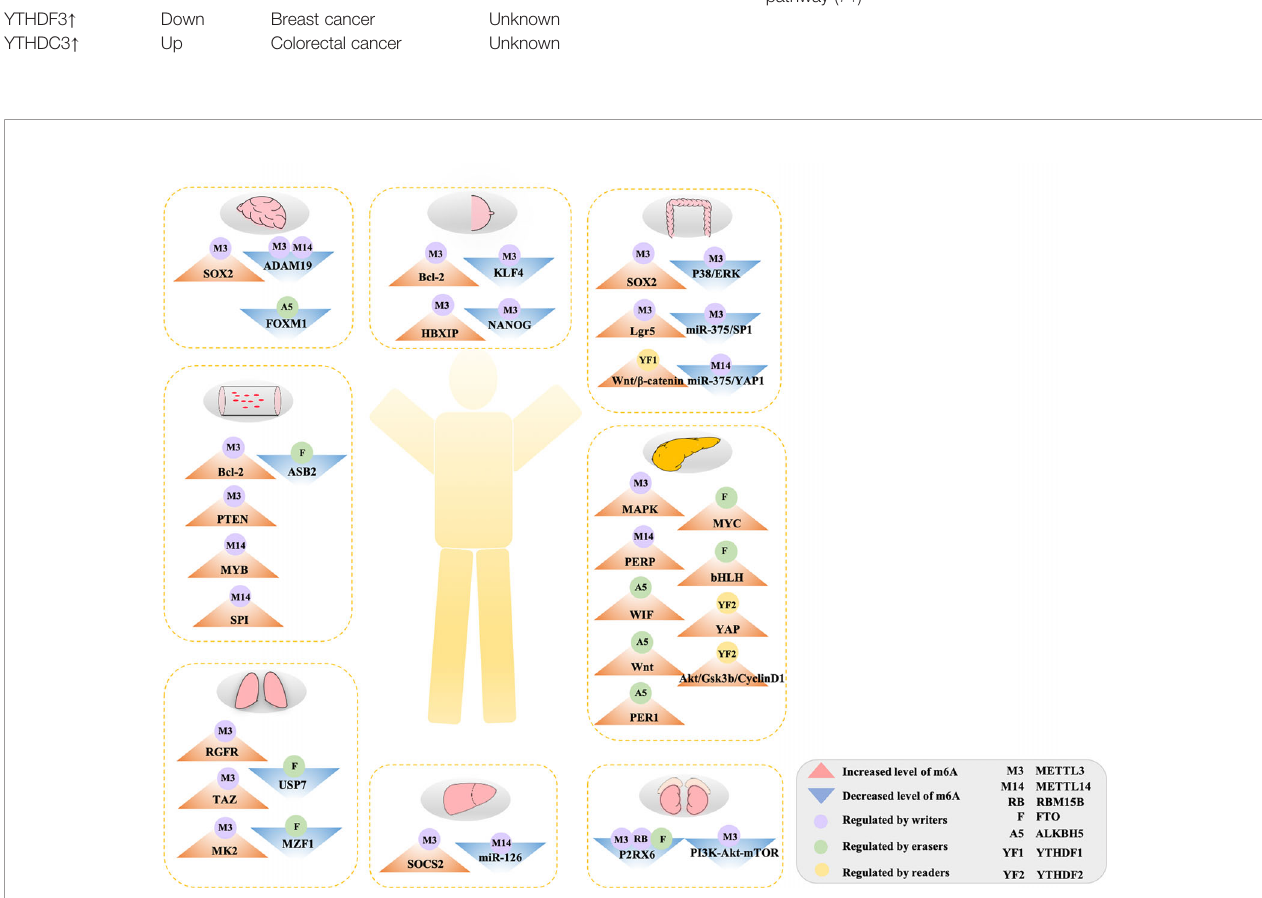
FIGURE 2 | The double-edged role of m6A methylation in human cancers. Aberrant m6A modi fi cation regulated by diverse m6A-related regulators targeted on various genes or pathway to accelerate to initiation and development in tumors. See main text for more